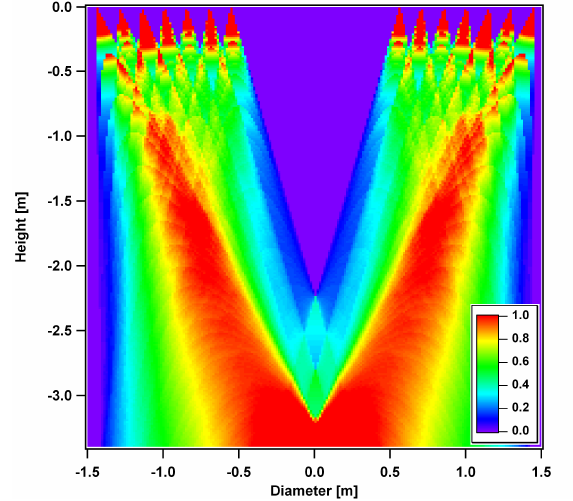
Fig. 3. UV illumination below 317nm inside the CLOUD chamber (Kupc et al., 2011). In the numerical simulations, H 2 SO 4 produc- tion was assumed to take place only in the parts of high UV intensity (red and yellow